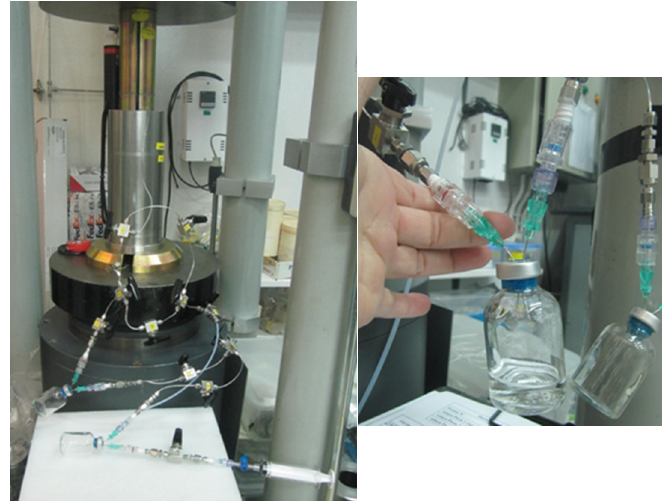
Figure 4. Squeezing technique for collecting the pore water from bentonite